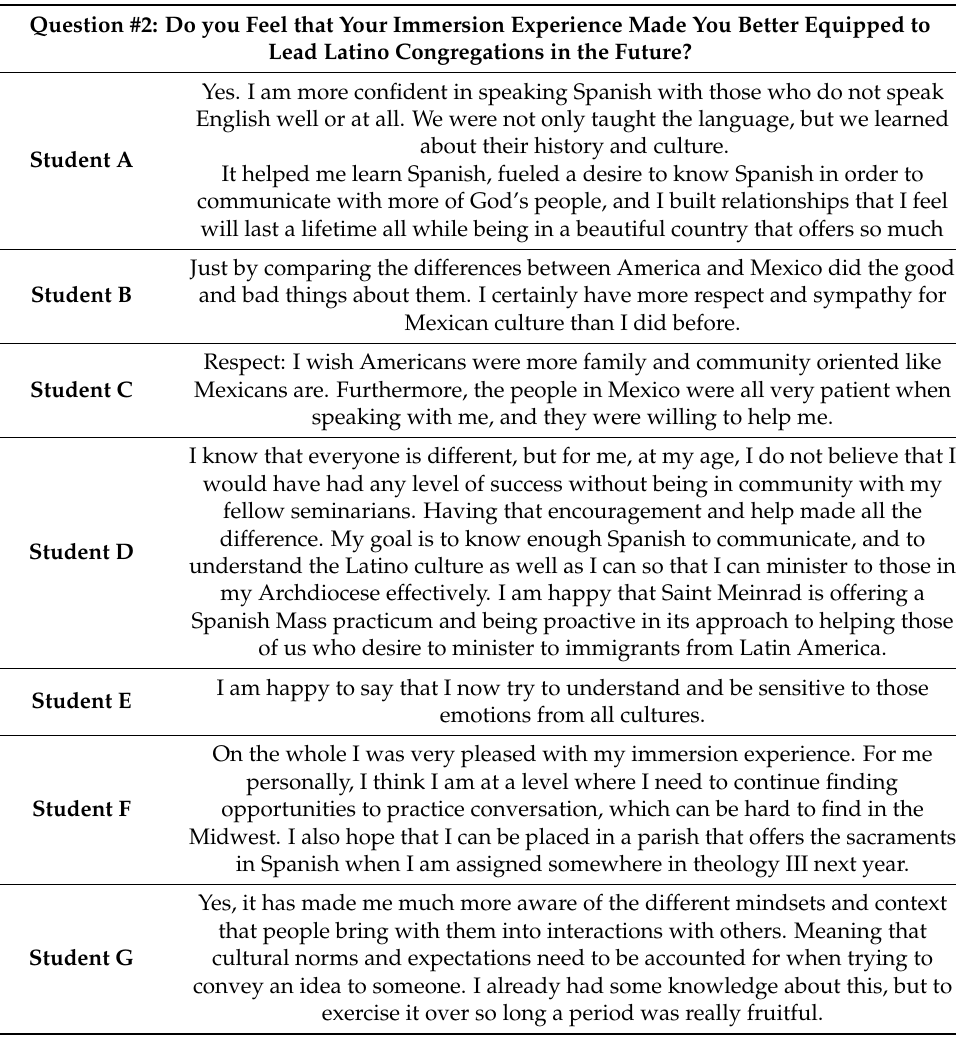
Table 6. Question